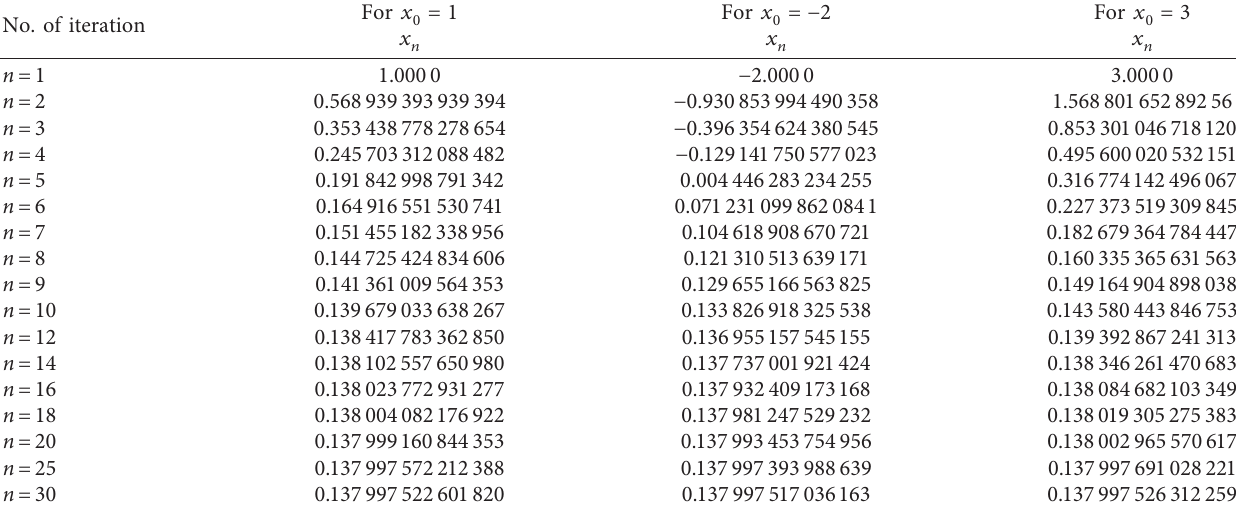
� 1, x � − 2, and x � 0 0 0